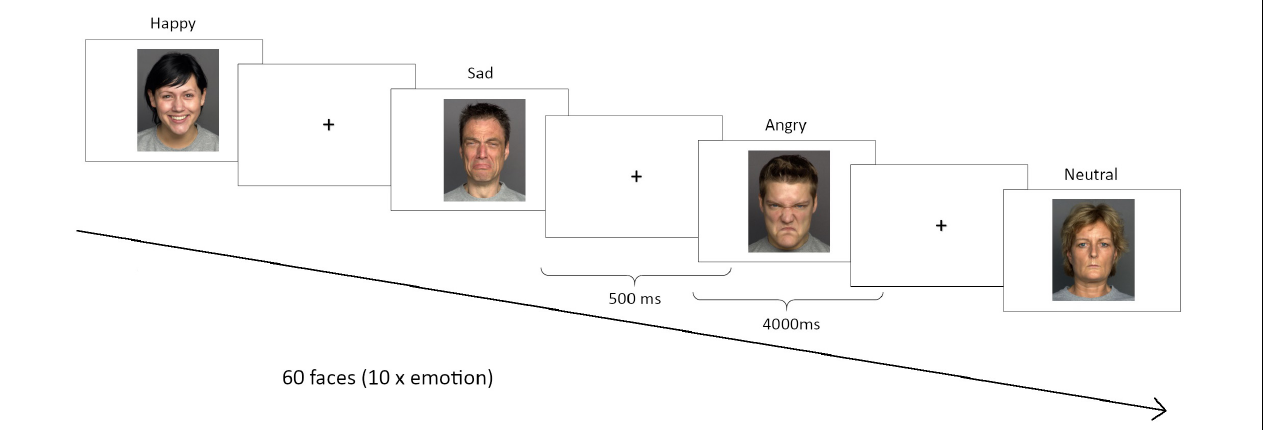
FIGURE 1 | Emotion recognition task. Three different versions were performed in each correspondent session. During each session, participants viewed 60 faces from the FACES database (http://faces.mpib-berlin.mpg.de/), 10 for each emotion: anger, sadness, happiness, disgust, fear or neutral.